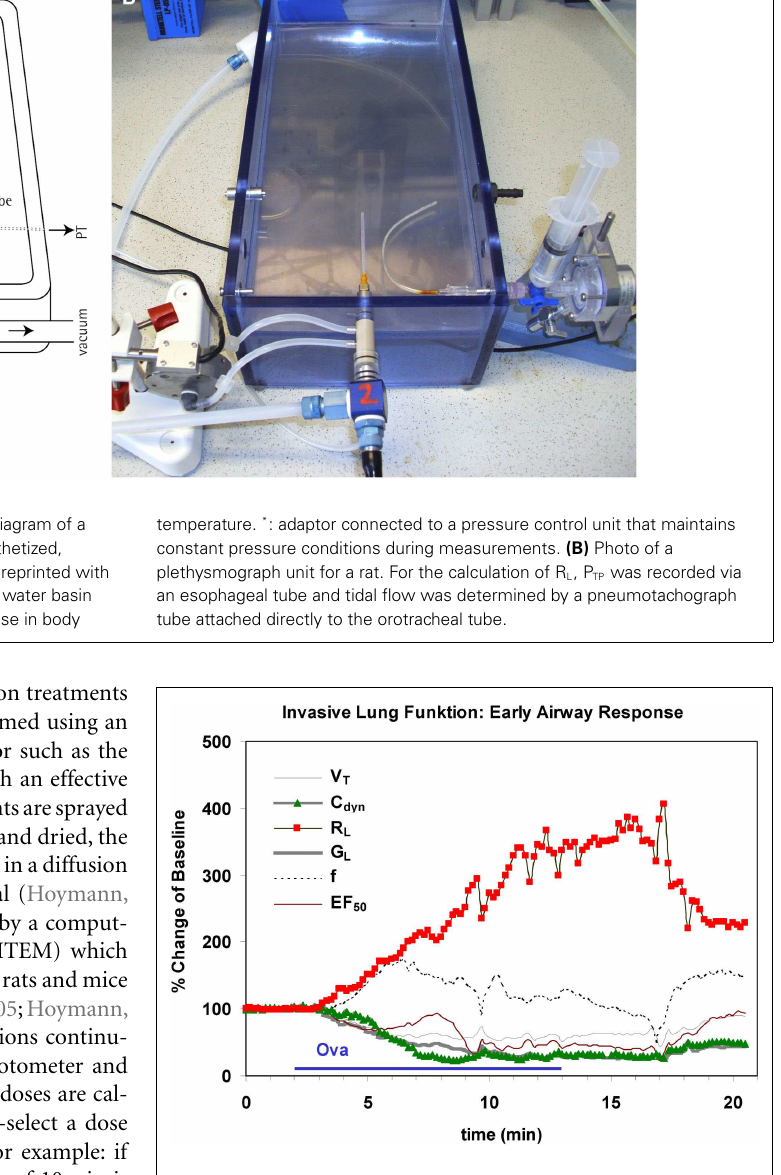
FIGURE 6 | Characteristic time course of an early airway response in an anesthetized, orotracheally intubated Brown Norway rat during and after inhalational challenge with ovalbumin. Marked increase in lung resistance (R L ) is shown and a decrease in dynamic compliance (C dyn ) is paralleled by decreases in lung conductance ( G L ), midexpiratory flow (EF 50 ) and tidal volume ( V T ). Also a slight increase in respiratory frequency ( f ) was observed.The x-axis represents the experimental time (unit =